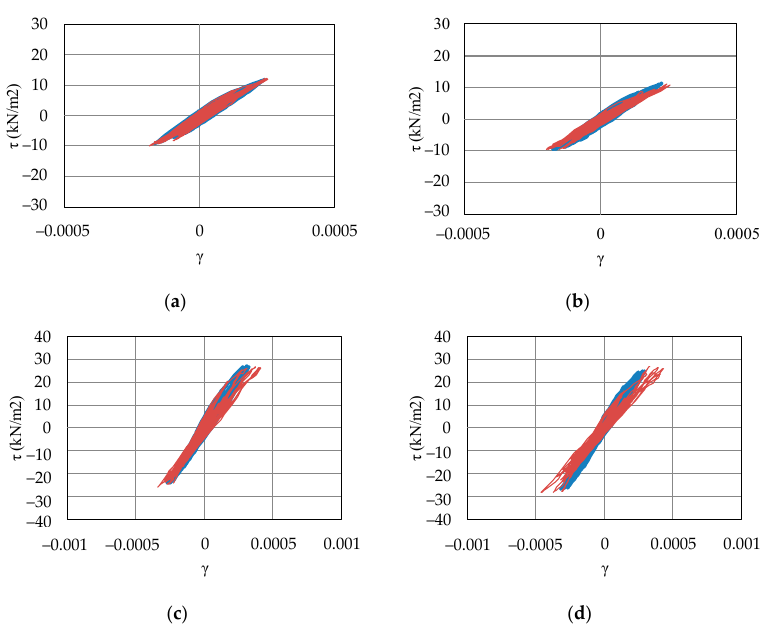
Figure 12. Shear stress–shear strain relations: ( a ) the response in YZ direction in upper layer of sand, ( b ) the response in ZX direction in upper layer of sand, ( c ) the response in YZ direction in lower layer of sand, and ( d ) the response in ZX direction in lower layer of sand. Blue line is the response of the original model and red line is that of the proposed model.